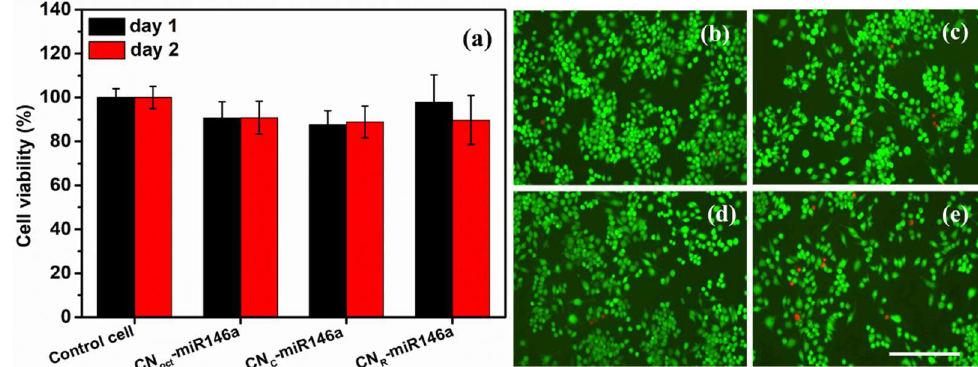
Figure 5. Cell viability and live/dead assay results of pure and miR146a conjugated octahedra, Cube, and rod CNPs samples. ( a ) shows the percentage of cell viability after 0.4 ng/μL of miR146a conju- gated different shapes of CNPs-treated cells. Non-treated cells were considered as the control. In addition, the merged image of live and dead cells for control cells (nanoparticles non-treated cells), and 0.4 ng/μL of miR146a conjugated different shapes of CNPs were shown in ( b – e ). The scale bar is 100 μM.